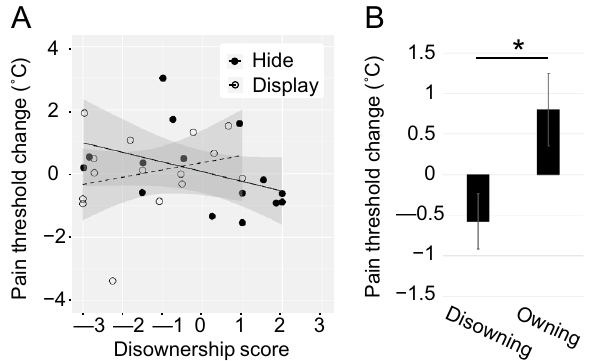
Figure 5. Pain threshold change from baseline measure. ( A ) Scatterplot showing the relationship between ownership disruption ratings and pain threshold change in the Hide (black circles, solid line) and Display (white circles, dashed line) conditions. Shaded area corresponds to 95% confidence intervals for the linear trends. ( B ) Averaged pain threshold changes of the two groups, where participants were classified into “Disowning” and “Owning” groups based on their disownership scores. Error bars represent the standard error. An asterisk indicates the statistical significance (* p <